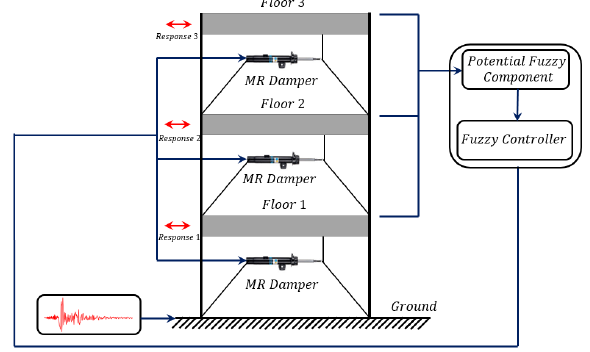
Figure 1. A schematic diagram for the modelled system